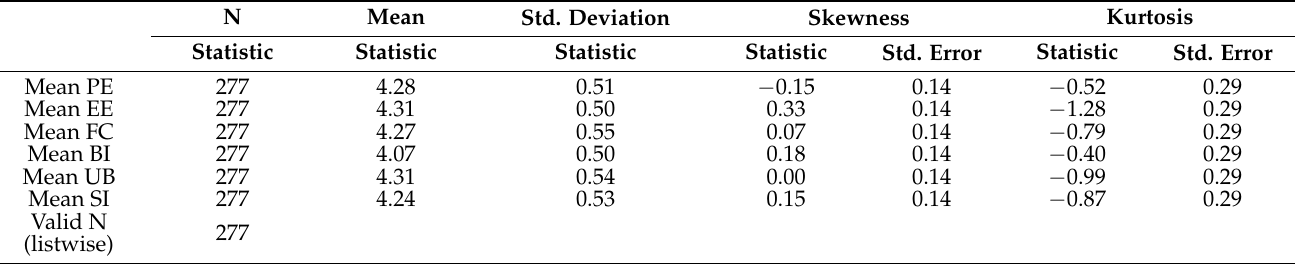
Table 3. Descriptive statistics of construct model.